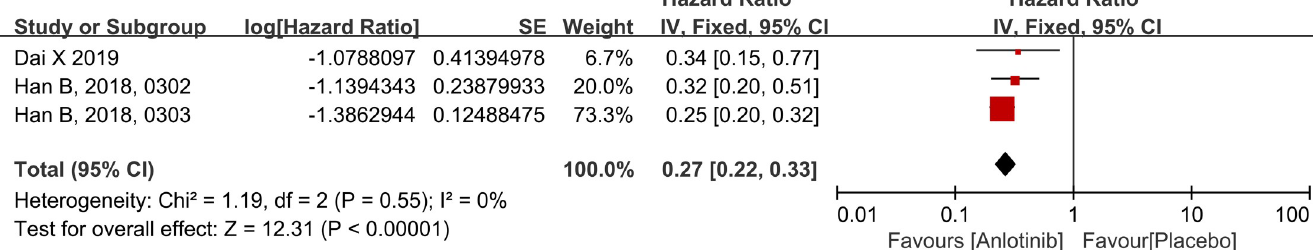
Fig 3. Forest plot comparing the PFS between anlotinib and placebo group in advanced NSCLC. The red squares represent the HR of a study, and the black line their confidence intervals. The black diamond represent the pooled HR and its confidence interval.